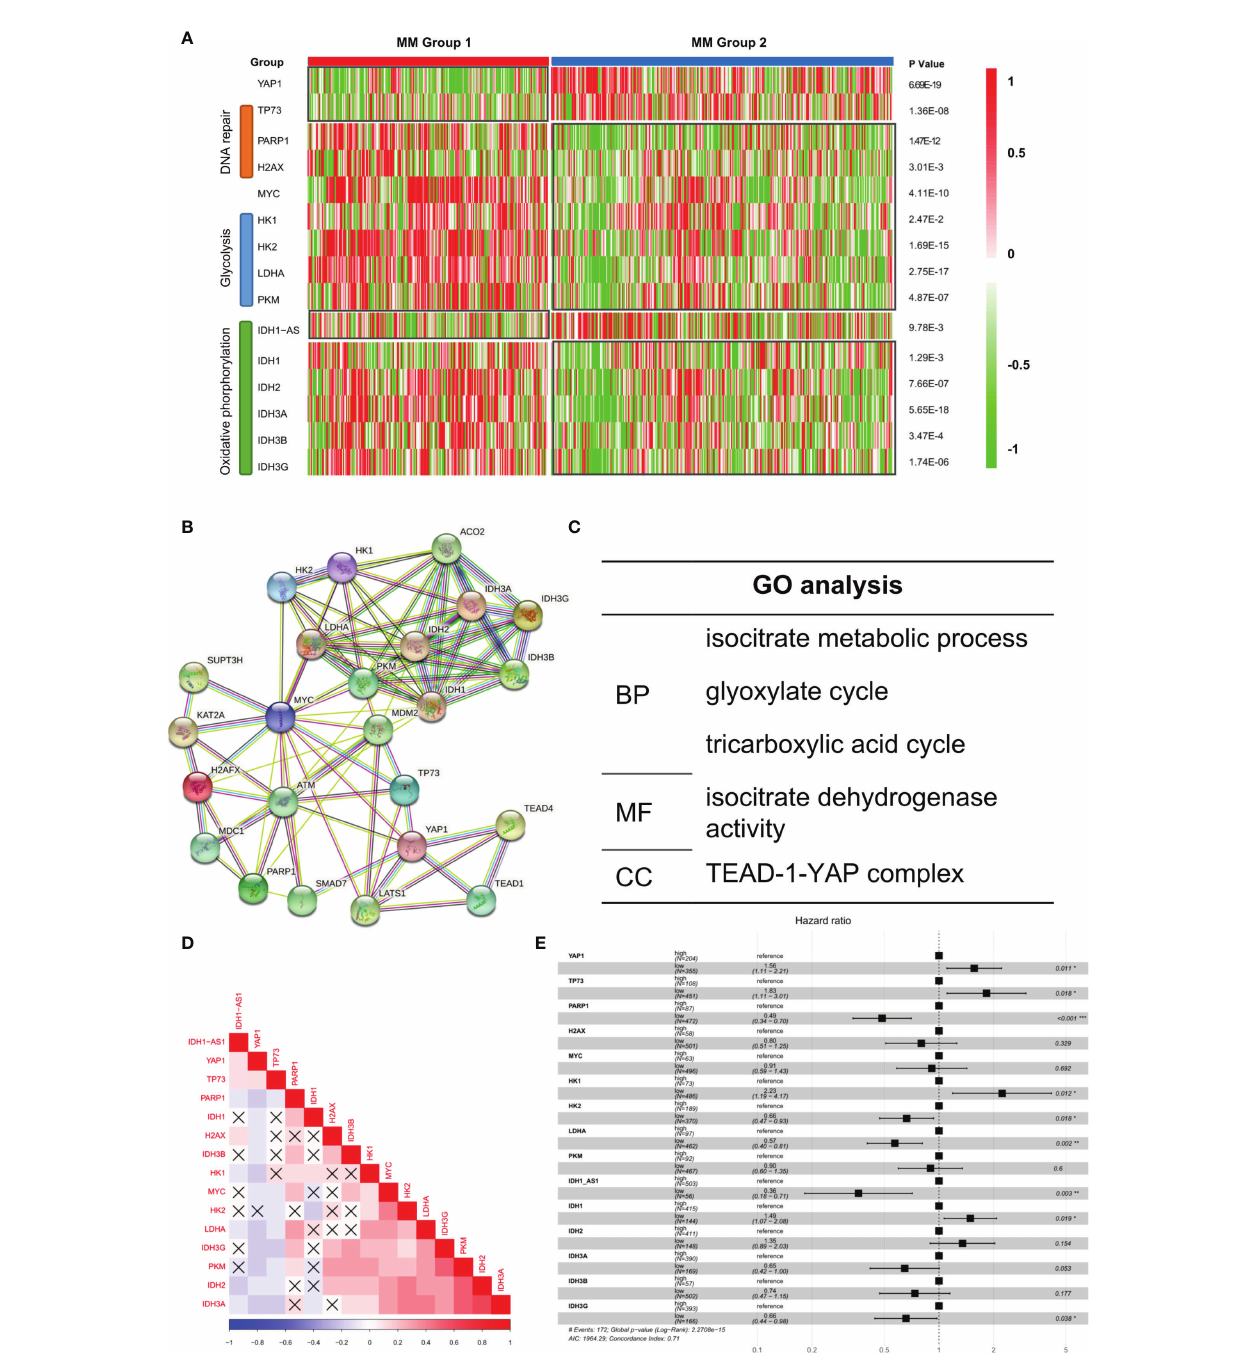
FIGURE 4 | Aberrant biological processes in YAP1-low expressed MM cases enhanced its oncogenicity. (A) Heatmap of the expression level of YAP1/MYC along with DNA repair/glycolysis/oxidative phosphorylation-related genes in MM group 1 and 2. (B, C) Protein – protein interaction network of YAP1/MYC along with DNA repair/Glycolysis/Oxidative phosphorylation-related genes based on the STRING online database and GO term enrichment analysis. (D) Heatmap of the correlation of YAP1/MYC along with DNA repair/glycolysis/oxidative phosphorylation-related genes. p -value > 0.05 was annotated with an error mark. (E) Forest plot shows the univariate result of YAP1/MYC along with DNA repair/glycolysis/oxidative phosphorylation-related genes in